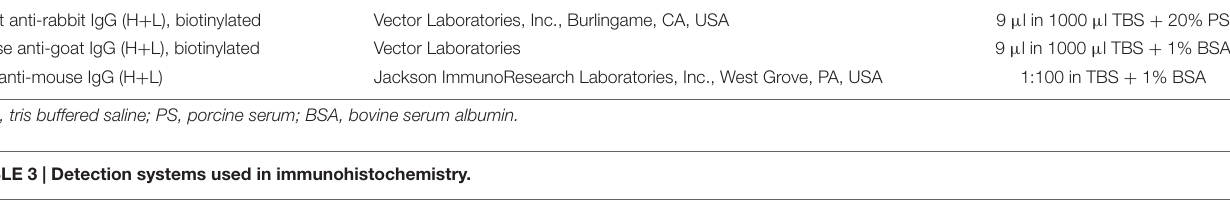
TABLE 2 | Secondary antibodies used in immunohistochemistry. Secondary antibody